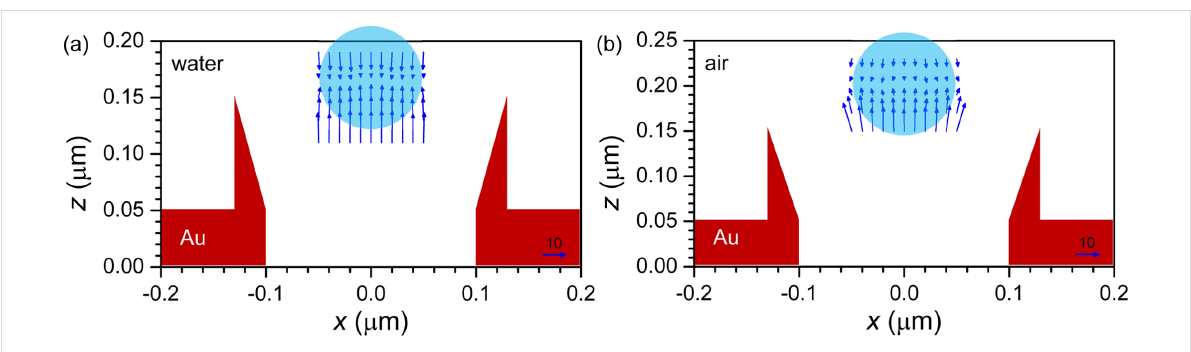
Figure 6: Arrow plot of the trapping force as in Figure 5 at 760 nm wavelength for a 100-nm diameter bead in (a) water and (b) air. The scale arrows at the lower right indicate a force of 10 pN/W/ μ m 2